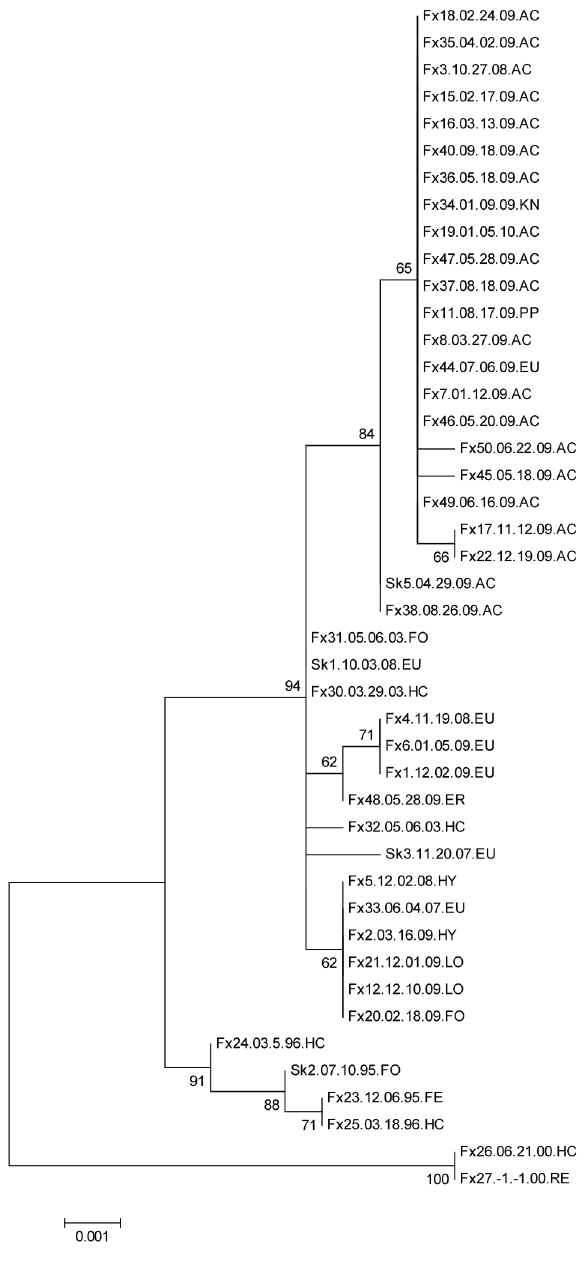
Figure 3. Phylogram generated from G gene nucleotide sequences of Humboldt Co. skunk variant rabies samples. The evolutionary history was inferred by using the Maximum Likelihood method as described for Figure 1. The analysis involved 44 nucleotide sequences. All positions with less than 95% site coverage were eliminated. There were a total of 1498 positions in the final dataset. Samples and regions are labeled as previously described. No data regarding month or day of sample collection was available for sample Fx27, this missing information is shown in the sample label as ‘‘-1-1.00’’ to denote the year of collection as being